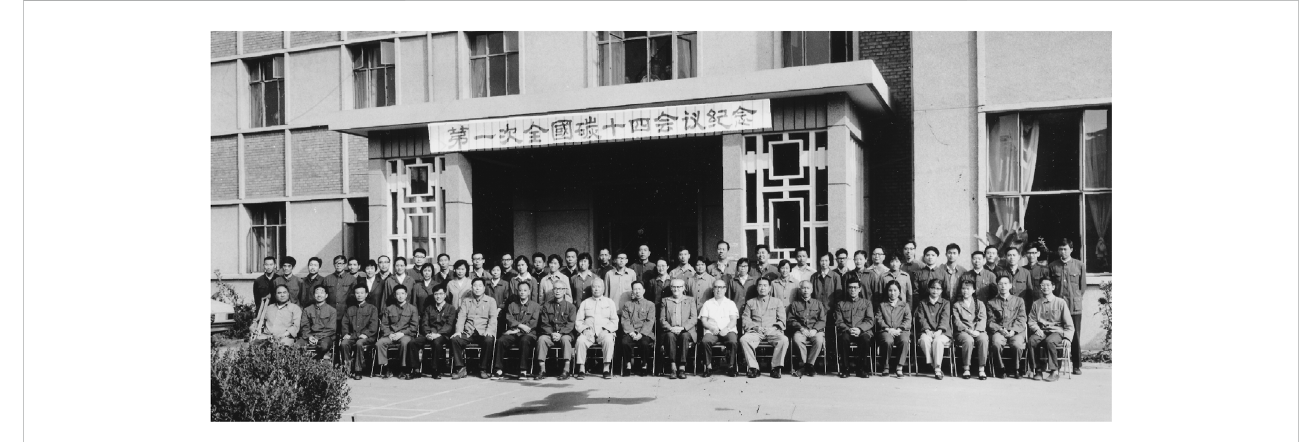
FIGURE 1 First national conference on 14 C in China